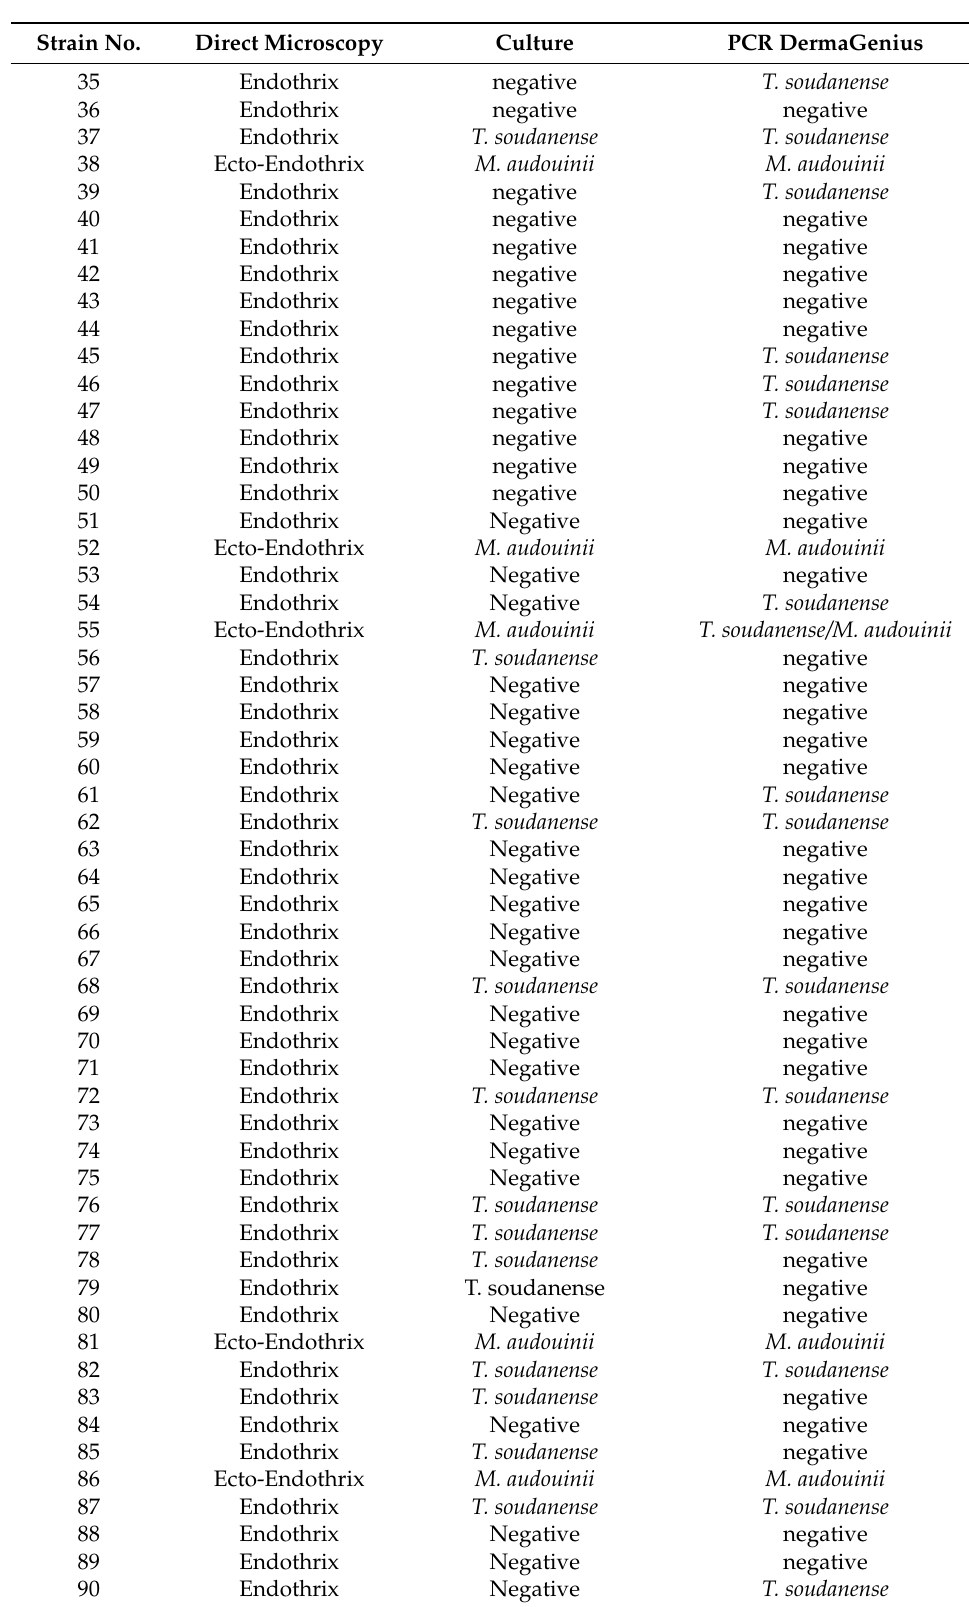
Table 1. Cont. Strain